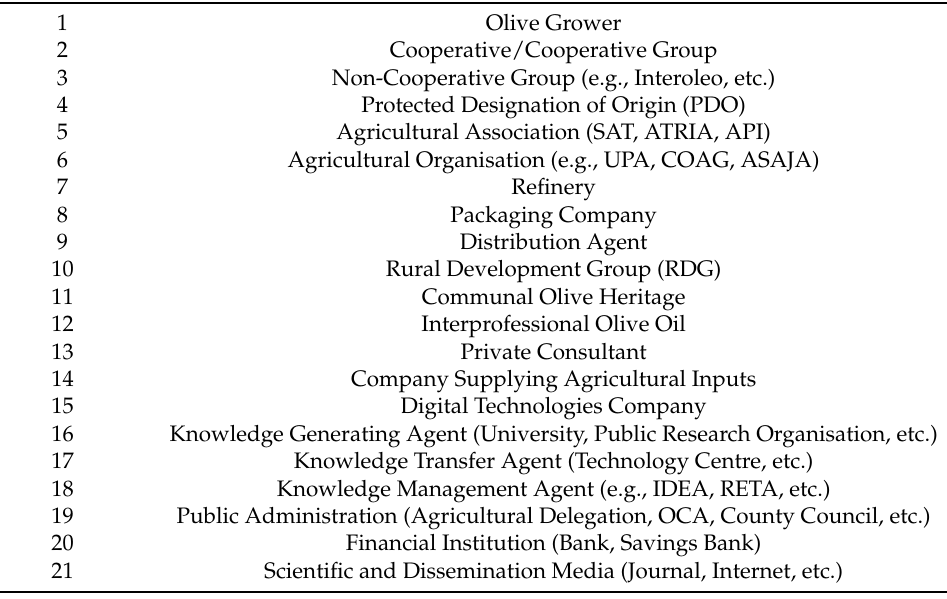
Table 2. Types of actors in the TIS of DT in the Andalusian olive